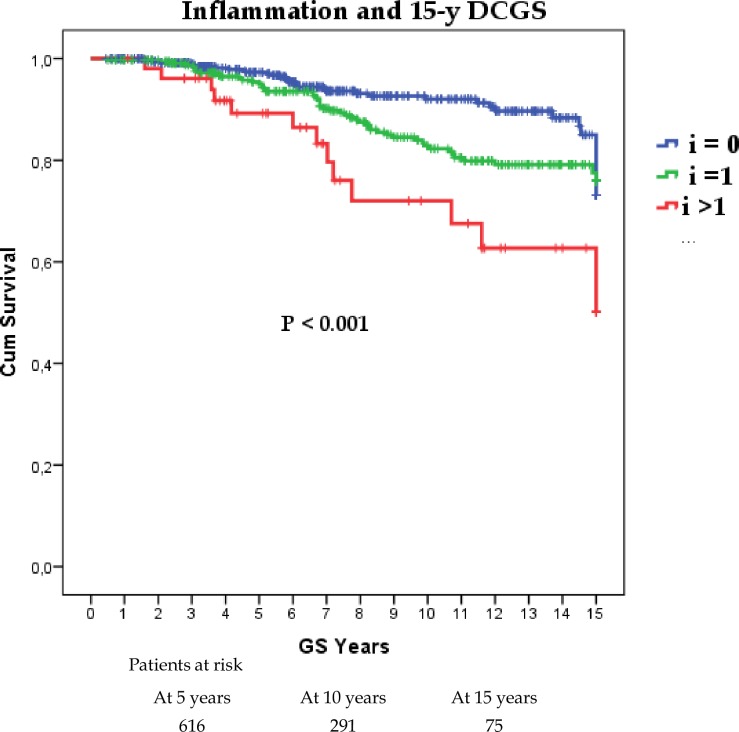
Impact of inflammation severity on death censored graft survival.